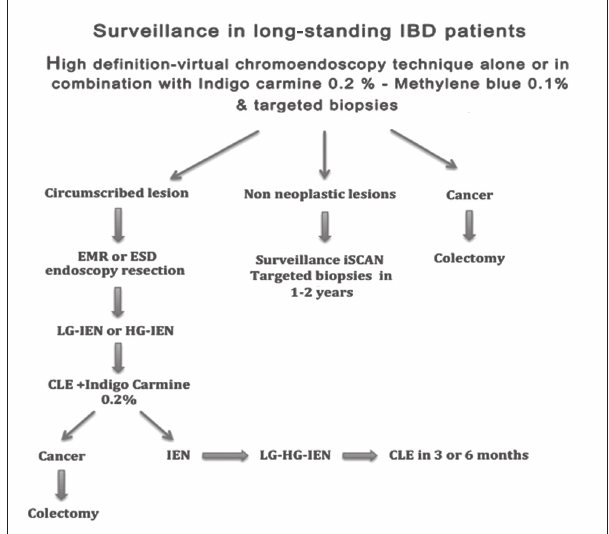
Figure 5) Flow chart illustrating the proposed strategy for surveillance and management of dysplasia in inflammatory bowel disease (IBD). CLE Confocal laser endoscopy; ESD Endoscopic submucosal dissection; EMR Endoscopic mucosal resection; HG-IEN High-grade intraepithelial neo- plasia; LG-IEN Low-grade intraepithelial